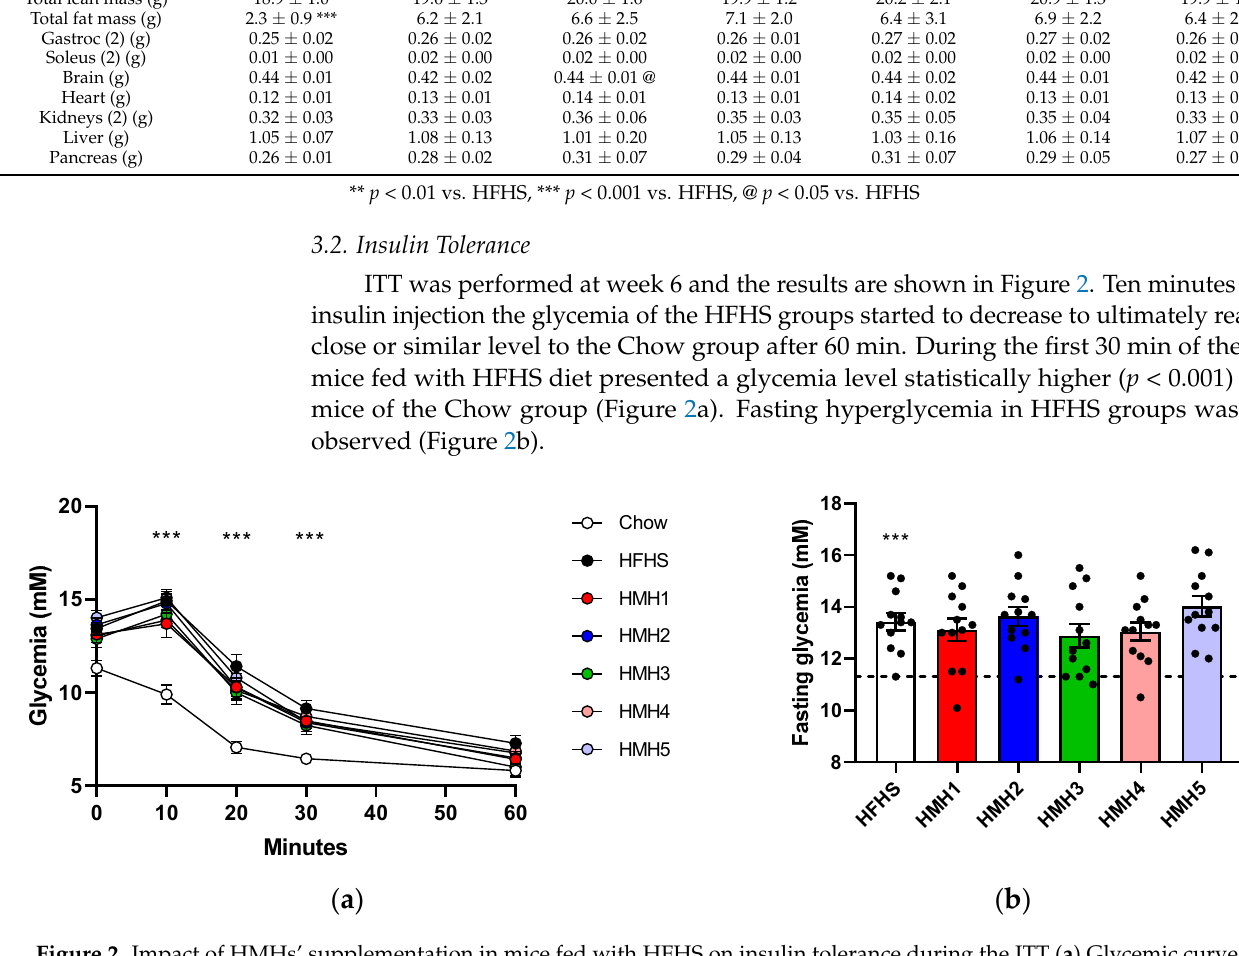
Figure 2. Impact of HMHs’ supplementation in mice fed with HFHS on insulin tolerance during the ITT ( a ) Glycemic curve as a function of time after administration of insulin ( b ) Blood glucose concentration was measured at t = 0 after 6 h of fasting. *** p ˂ 0.001 Chow vs. HFHS.